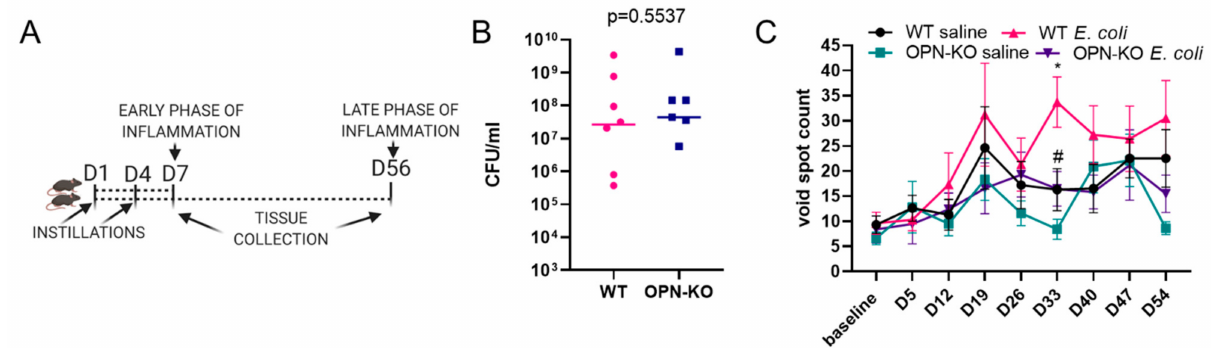
Figure 2. E. coli -induced urinary dysfunction is ameliorated in osteopontin knockout (OPN-KO) mice. Panel ( A ) shows ex- perimental set up for the acute and chronic inflammatory time points. Wild type (WT) or OPN-KO mice were transurethrally instilled with E. coli or saline two times, 3 days apart, and were euthanized at day 7 (acute inflammation) or 56 (chronic inflammation). Panel ( B ) shows that colony forming units (CFUs) in free-catch urine were not significantly different between WT and OPN-KO mice 24 h after instillation. One data point from each group was zero, and these were not added to the figure but were included in the statistical analysis. Panel ( C ) shows void spot counts sized 0–0.1 cm 2 measured weekly throughout the course of the chronic experimental set up. Significant differences were found WT saline vs. WT E. coli (*) and WT E. coli vs. OPN-KO E coli (#) at day 33 using Mann–Whitney test. *,# p <